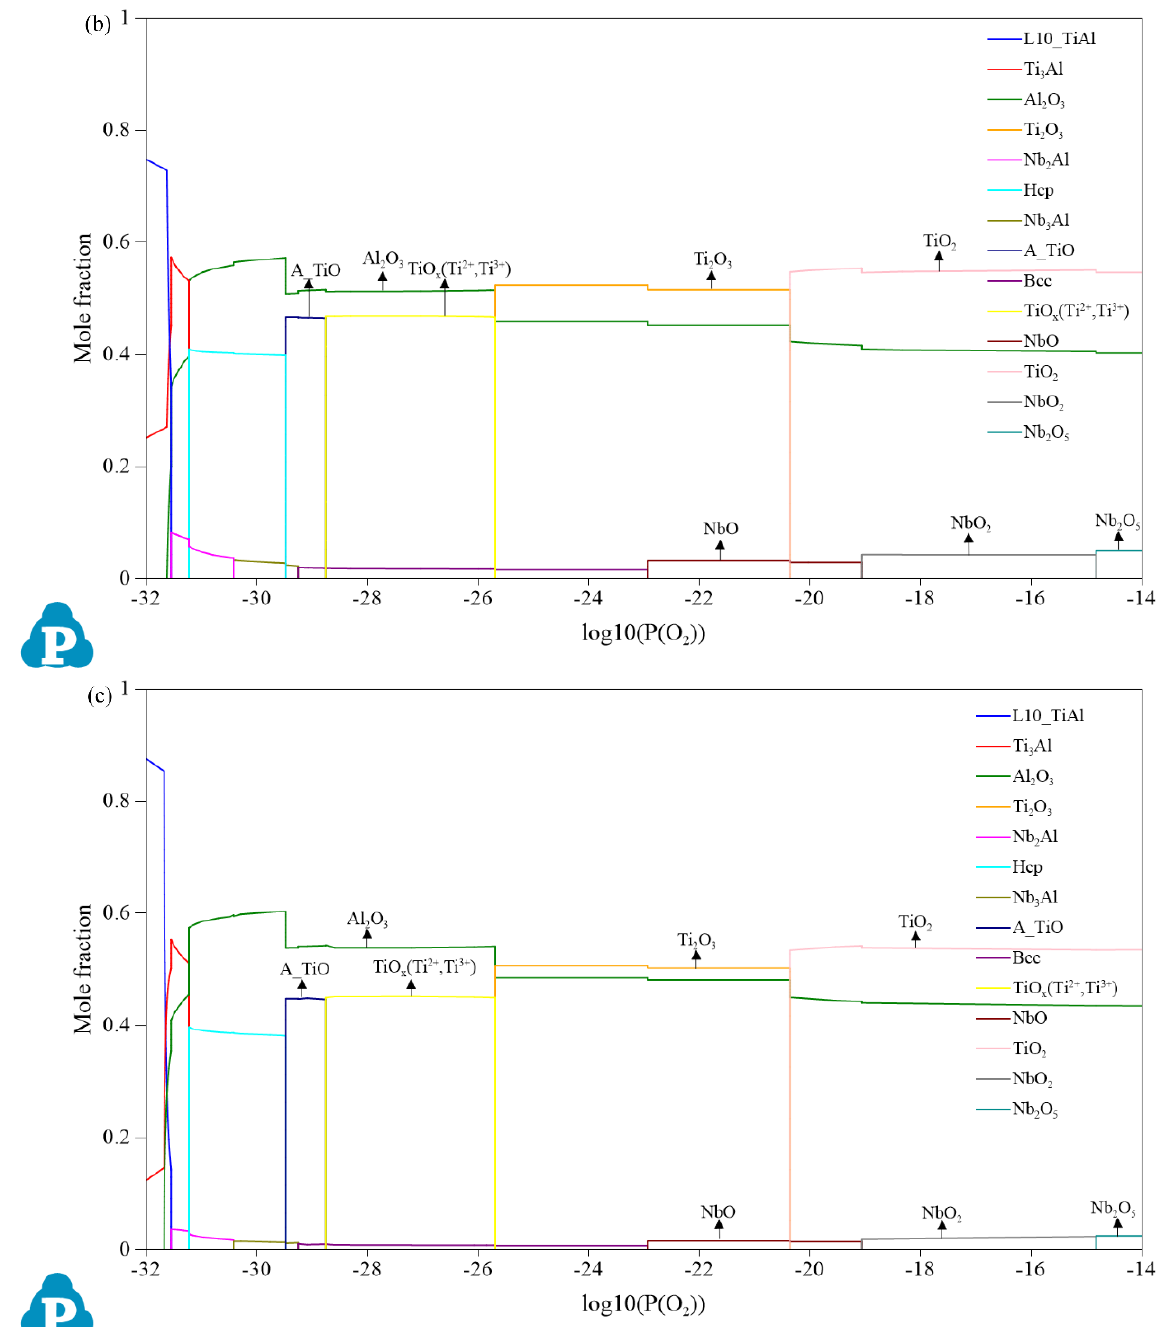
Figure 4. Variation of the oxide mole fractions at different O 2 partial pressure at 900 °C: ( a ) Ti-42Al- 8Nb, ( b ) Ti-45Al-4Nb, ( c ) Ti-48Al-2Nb.